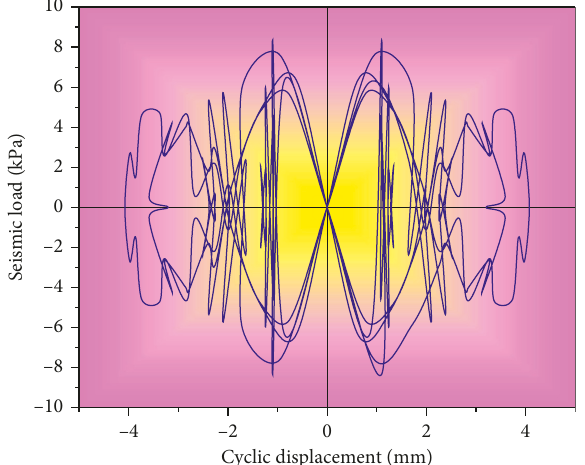
Figure 6: Seismic load (kPa) vs cyclic displacement (mm) at the base of a concrete footing,